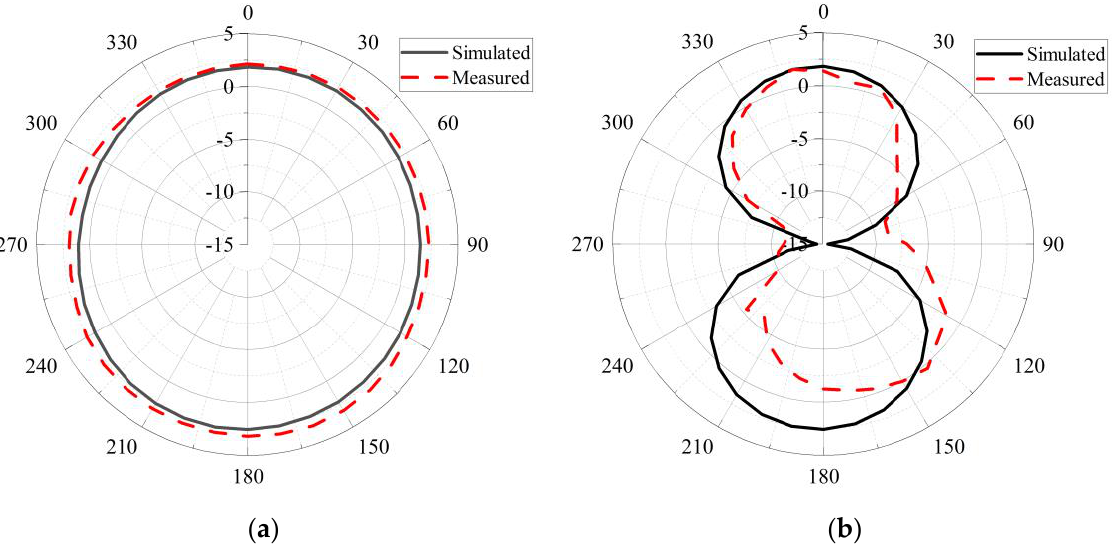
Figure 8. Simulated and measured radiation pattern in the ( a ) xoz-plane and ( b ) yoz-plane at 6 GHz.